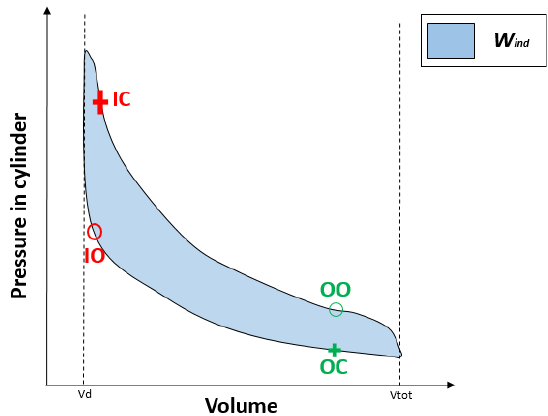
Figure 4. Scheme of P - V diagram.